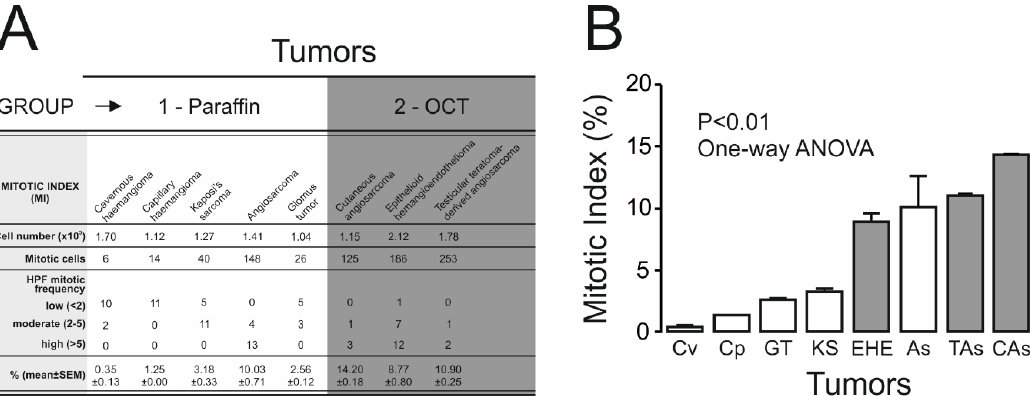
Figure 5. Mitotic index of tumors. Histological patterns were identified, and the mitotic index (MI) was evaluated from the hematoxylin-eosin stained samples. ( A ) The MI was calculated by counting all mitotic events present in 10 high-power fields (HPF) at 400× magnification. HPF, based on the frequency of mitosis, were classified as low (<2 mitosis in 10 HPF), moderate (2–5 mitosis in 10 HPF) or high (>5 mitosis in 10 HPF). The % values indicate the percentage of mitotic cells compared with the total number of cells evaluated. OCT-frozen malignant tumor samples are identified by a dark gray box. ( B ) The MI plotted against the tumor type. Values from panel A were plotted versus tumors, and the malignancy for each cancer was determined. While white bars represent paraffin-embedded samples, gray bars indicate OCT samples. Values are represented as the mean ± SEM; p < 0.01 (one-way ANOVA).